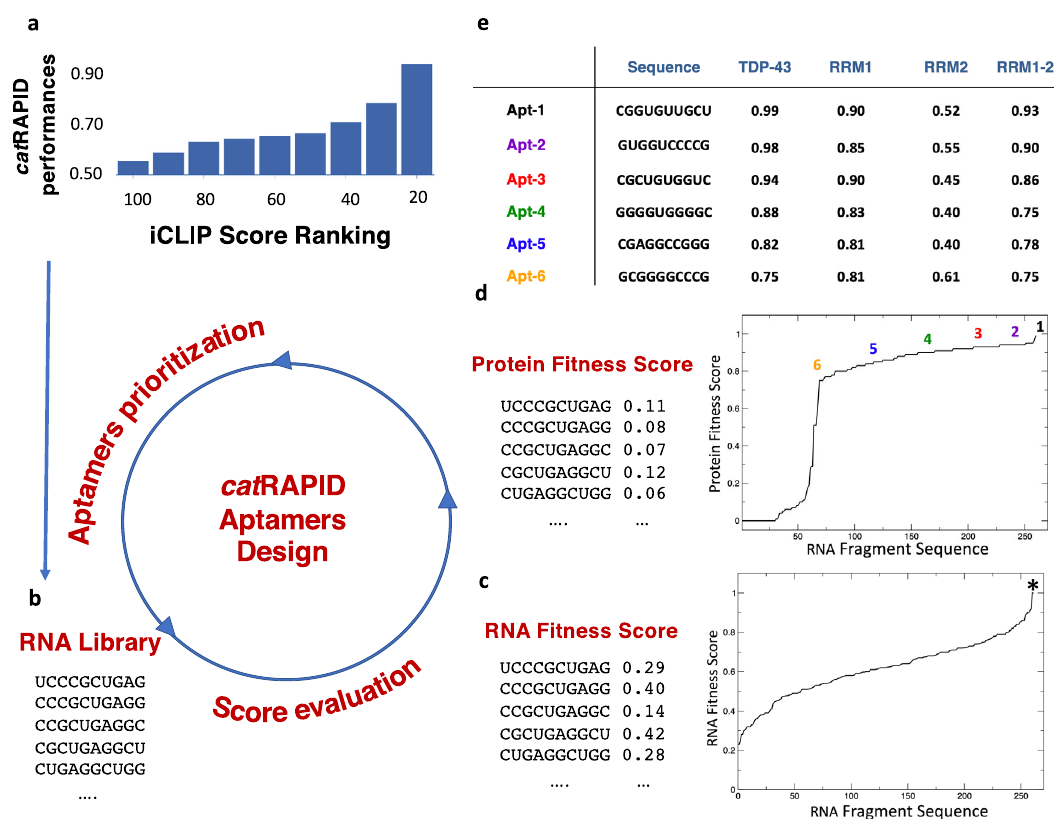
Fig. 1 In silico design of RNA aptamers. Sketch of the computational pipeline. a TDP-43 interaction propensity computed with catRAPID is used to discriminatebetween interacting (high iCLIP score) and non-interacting (low iCLIP scores) transcriptomic regions. The iCLIP scores were ranked from low (100 transcriptomic regions with the highest iCLIP score vs 100 transcriptomic regions with the lowest iCLIP score) to high (20 transcriptomic regions with the highest iCLIP score vs 20 transcriptomic regions with the lowest iCLIP score). catRAPID performances increase with the strength of the iCLIP score, indicating that the algorithm can accurately identify strong-signal interactions. b Using the 30 top-interacting transcriptomic regions we generated a list of fragments using a sliding window of 10 nucleotides moved from the 5 ′ to 3 ′ of each sequence. c The RNA Fitness score was employed to measure the strengthof catRAPID interaction propensities upon mutation of the RNA fragment sequence. Examples of RNA fragments and their relative RNA Fitness scores are shown on the left panel. On the right panel, the RNA Fitness scores of all the RNA fragments generated are given (candidate aptamers were marked with a star). d The Protein Fitness score measures the strength of interaction propensity of each RNA sequence for TDP-43 in comparison with a pool of protein sequences with the same length and amino acid composition. Examples of RNA fragments and their Protein Fitness scores are shown on the left panel. On the right panel, the RNA Fitness scores of the RNA fragments generated are given (candidate aptamerswere marked with different numbers and colors). e Summary of Protein Fitness scores for TDP-43 full-length, RRM1, RRM2, RRM1-2 sequences (the colors match the Protein Fitness reported in panel d